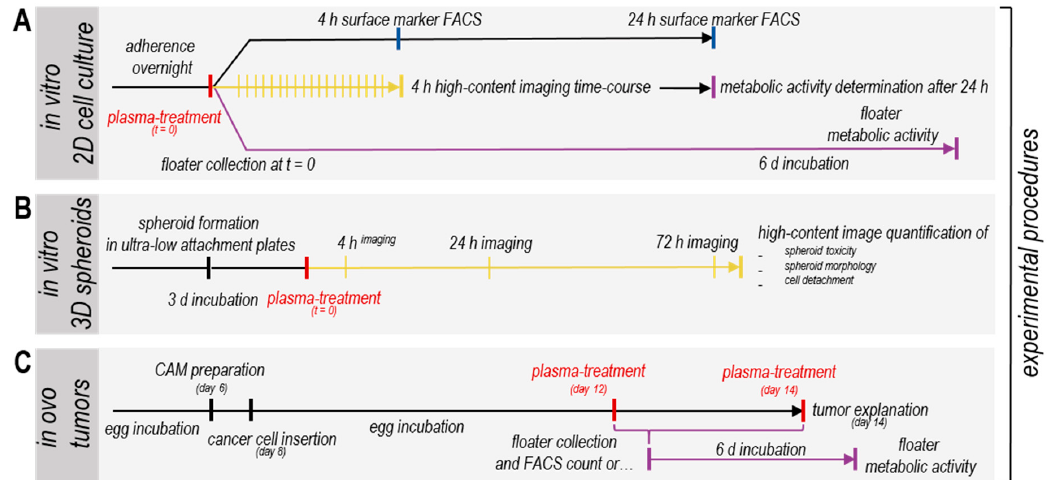
Figure 1. Schematic overview of the experimental setup. Experimental procedures for analysis of plasma effects on four human pancreatic cancer cell lines ( A ) in vitro using 2D cultures, ( B ) in vitro using 3D tumor spheroids and ( C ) in ovo using solid tumors. Time-points of experimental downstream analysis or high-content imaging are indicated as bars.